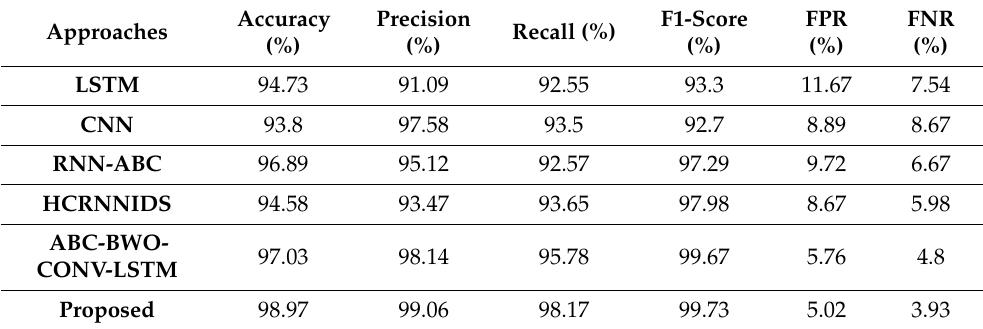
Table 12. Performance evaluation with existing approaches.